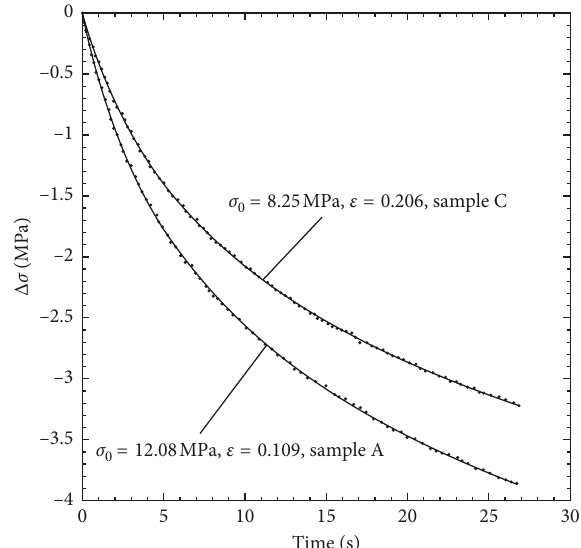
Figure 5: Details of the stress relaxation curves from Fig. 4 for sample A at ε 0.109 and sample C at ε 0.206. The logarithmic fits (cid:31) (cid:31) shown as the solid lines are in excellent agreement with the ex- perimental points (the fitted curve and experimental points overlap).